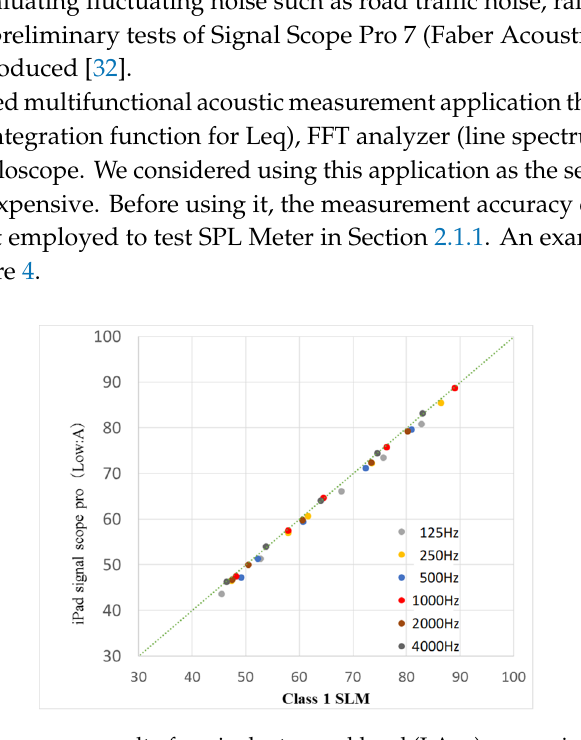
Figure 5. Example of sound map with Leq(A) (30 sec, Signal Scope Pro 7 on iPhone 5s), and sound spectrum (bs-spectrum on iPhone 5s): Ueno-higashi area, Toyonaka City, Osaka, Japan.